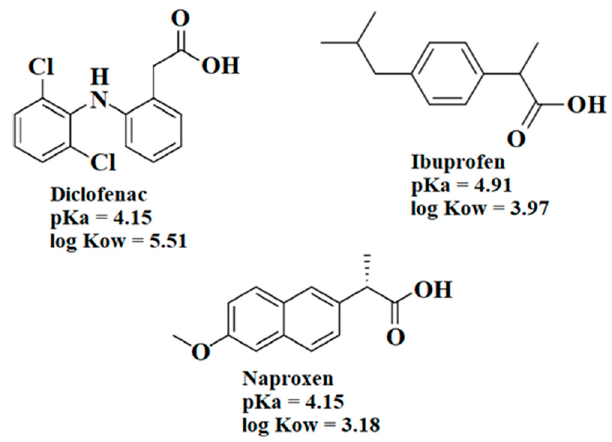
Figure 1. Structures of the studied organic micropollutants [10,11].